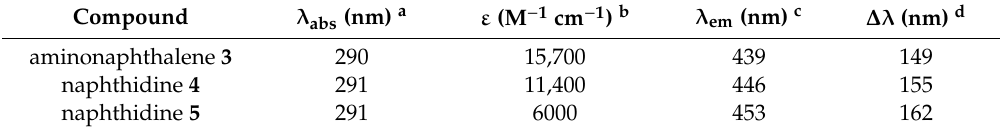
Figure 7. Fluorescence of the compounds 3 (left), 4 (center), and 5 (right) in methanol (concentration c = 2 mg mL − 1 ) by excitation with UV light ( λ ex = 254 nm). Table 1. UV absorption and fluorescence emission data of the compounds 3 , 4 , and 5 in methanol.